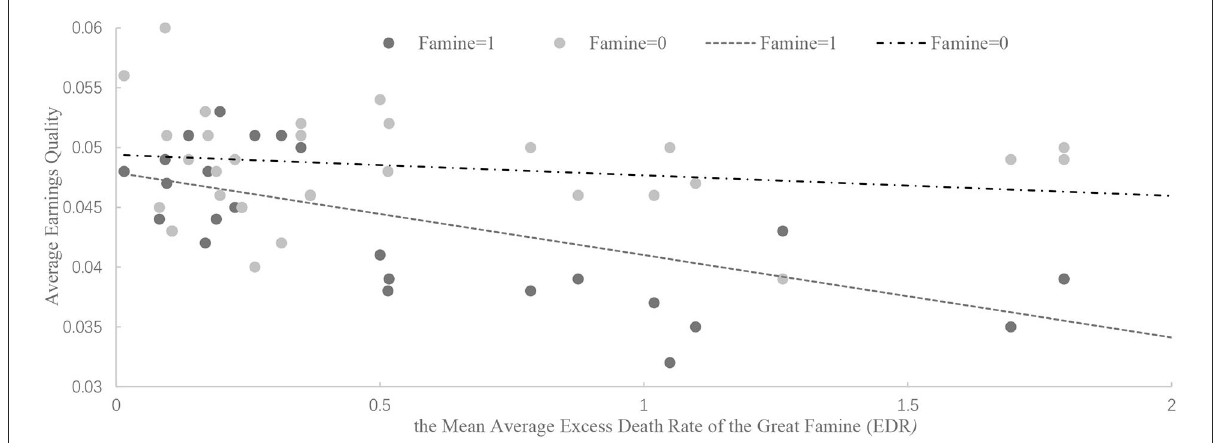
FIGURE2 Trend graph of the mean average excess death rate of the Great Famine (EDR) and the average corporate earnings quality. This figure shows the mean average excess death rate of the Great Famine (EDR) and the average corporate earnings quality. The sample is from Table 2. The X-axis is the mean average excess death rate (EDR). We use the following methods to calculate the EDR: calculating the difference in the average death rate between 1959–1961 and 1956–1958 for each province, and the difference in average death rates between 1959–1961 and 1962–1964 for each provinces; and then calculating the mean average excess death rate (EDR) using the above two differences to obtain the EDR for each province during 1959–1961. The Y-axis is the average earnings quality for each province. We draw two lines based on whether the CEO experienced the Great Famine .